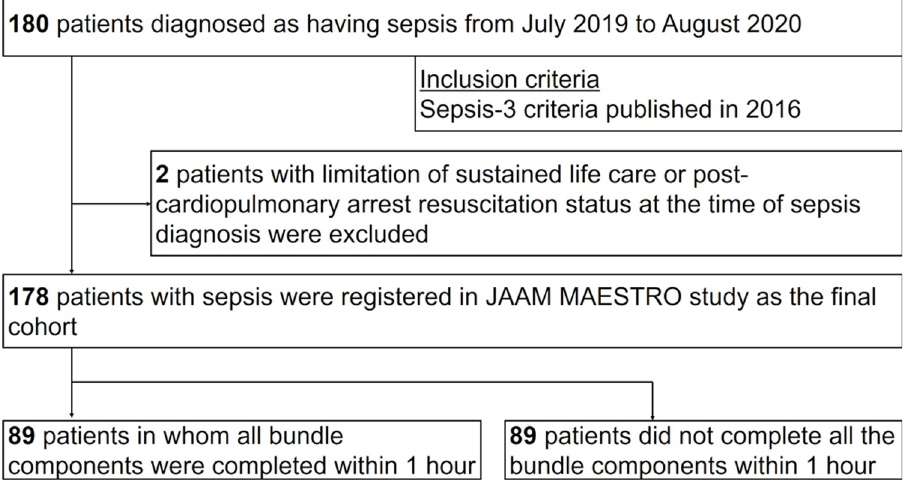
Fig 1. Patient flow diagram. JAAM MAESTRO Japanese Association for Acute Medicine Multicenter Assessment for Sepsis Treatment and Outcome.